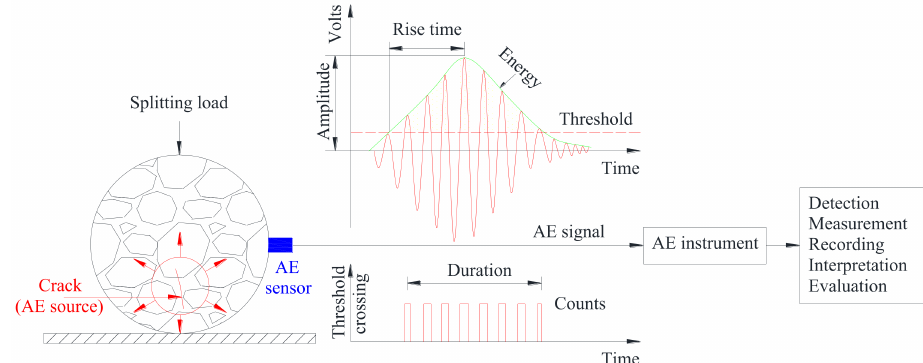
Figure 3. Schematic diagram of indirect tensile test for asphalt mixture monitored by AE.